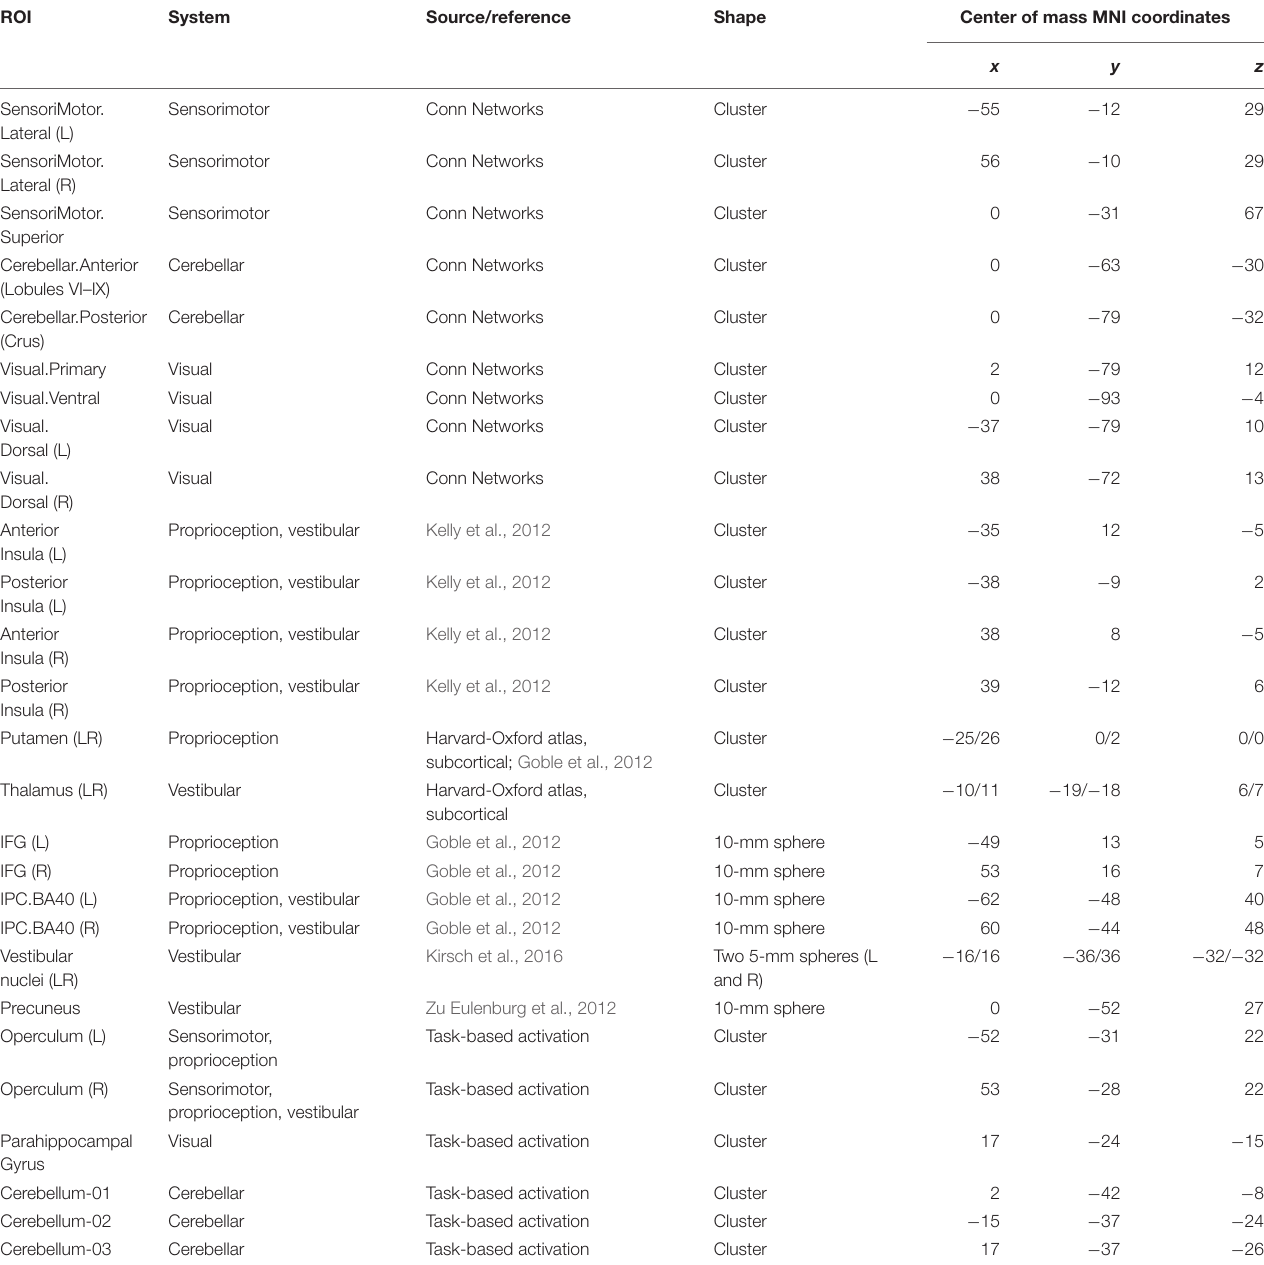
TABLE 2 | Characteristics of the ROIs selected for the ROI-to-ROI analysis of the functional connectivity between the sensorimotor, visual, proprioceptive, and vestibular systems. ROI System Source/reference Shape Center of mass MNI